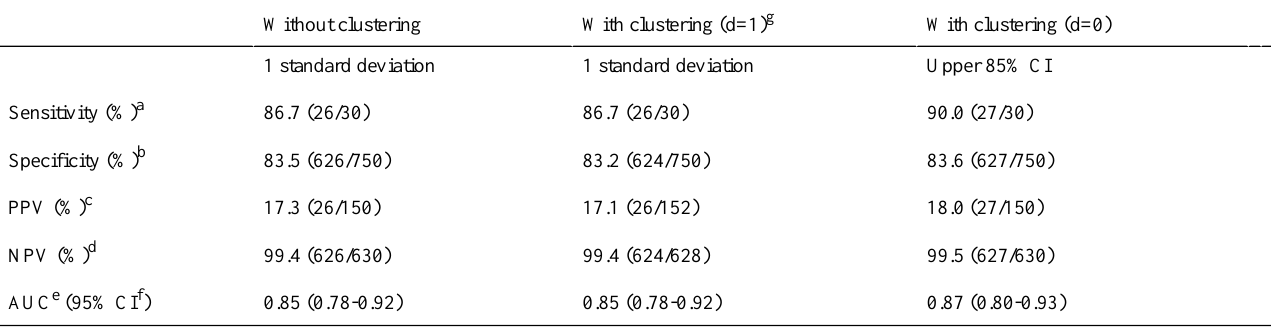
Table 3. Performance in outbreak detection according to patient criterion and a variety of upper control limits defined by 1 standard deviation and 85% confidence interval, with and without clustering.